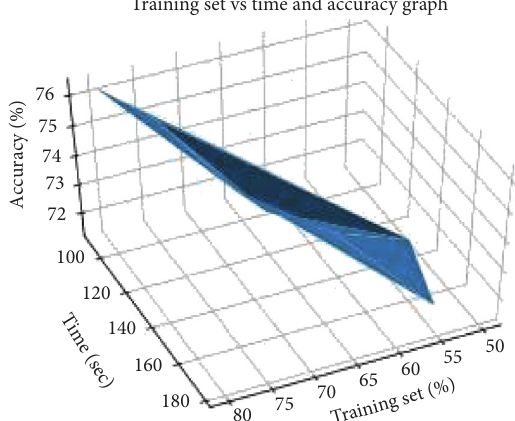
Figure 9: Recognition rates using an HOG-based feature set.